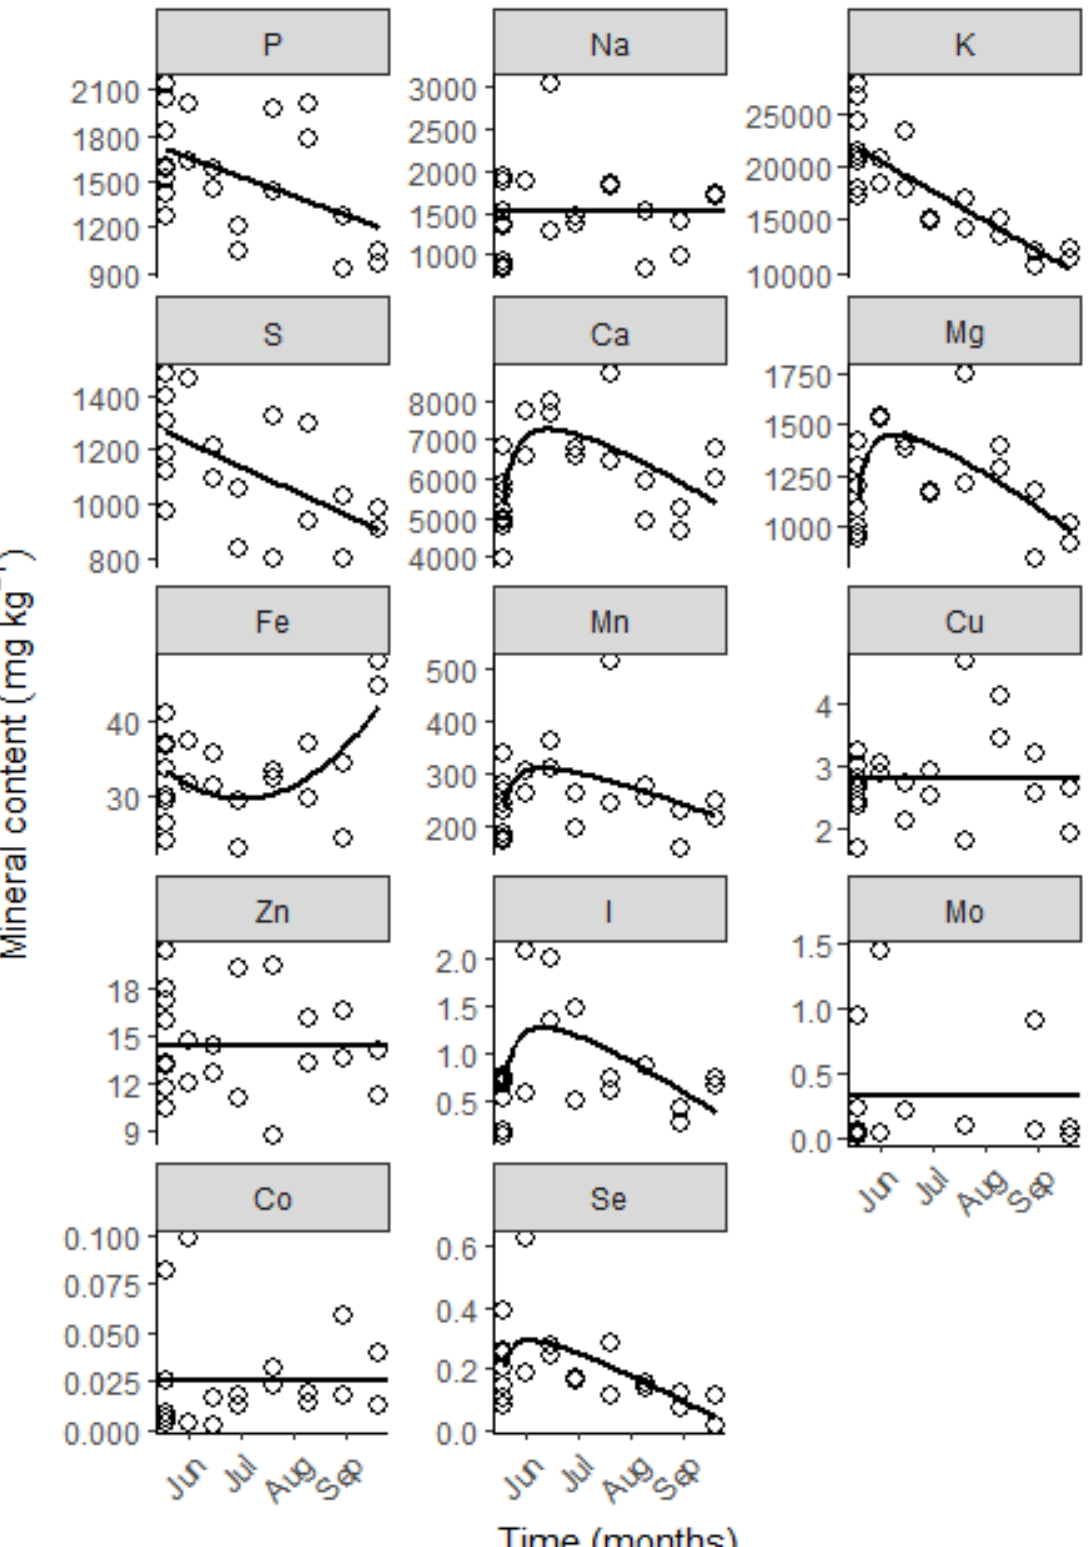
Figure 4. Experiment II: Effect of harvest day on the dry matter contents of minerals in T. latifolia biomass one year after planting. Harvest dates were 19 May, 02 June, 16 June, 30 J une, 21 July, 11 August, 01 September and 22 September 2017. Each set of points per harvest date (n ≥ 2) represents biomass mineral concentrations from two different subplots, harvested for the first time in the growing season. Fit parameters of the curves are shown in Table